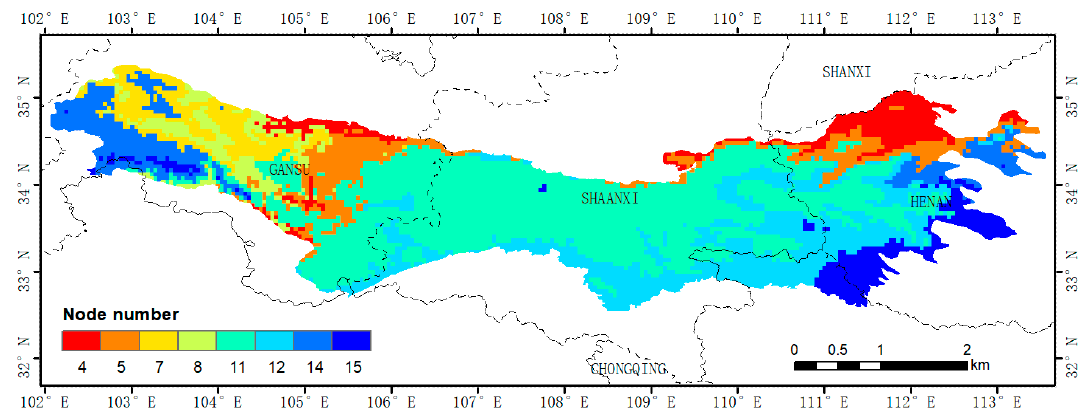
Figure 9. Spatial representation of the node membership derived from the sensitive analysis.